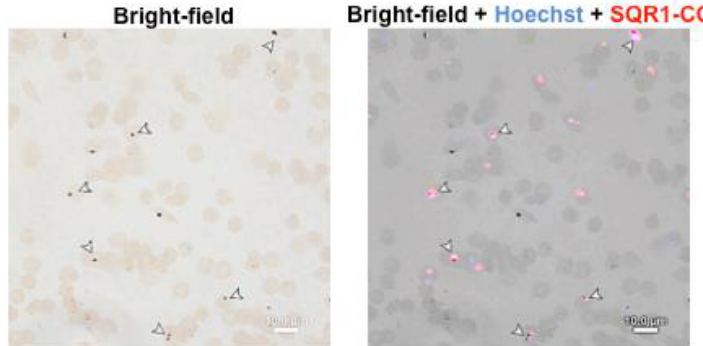
Figure 5 . Hoechst-SQR1-CQ co-staining of unfixed thin smears of 3D7 parasites on glass slides.